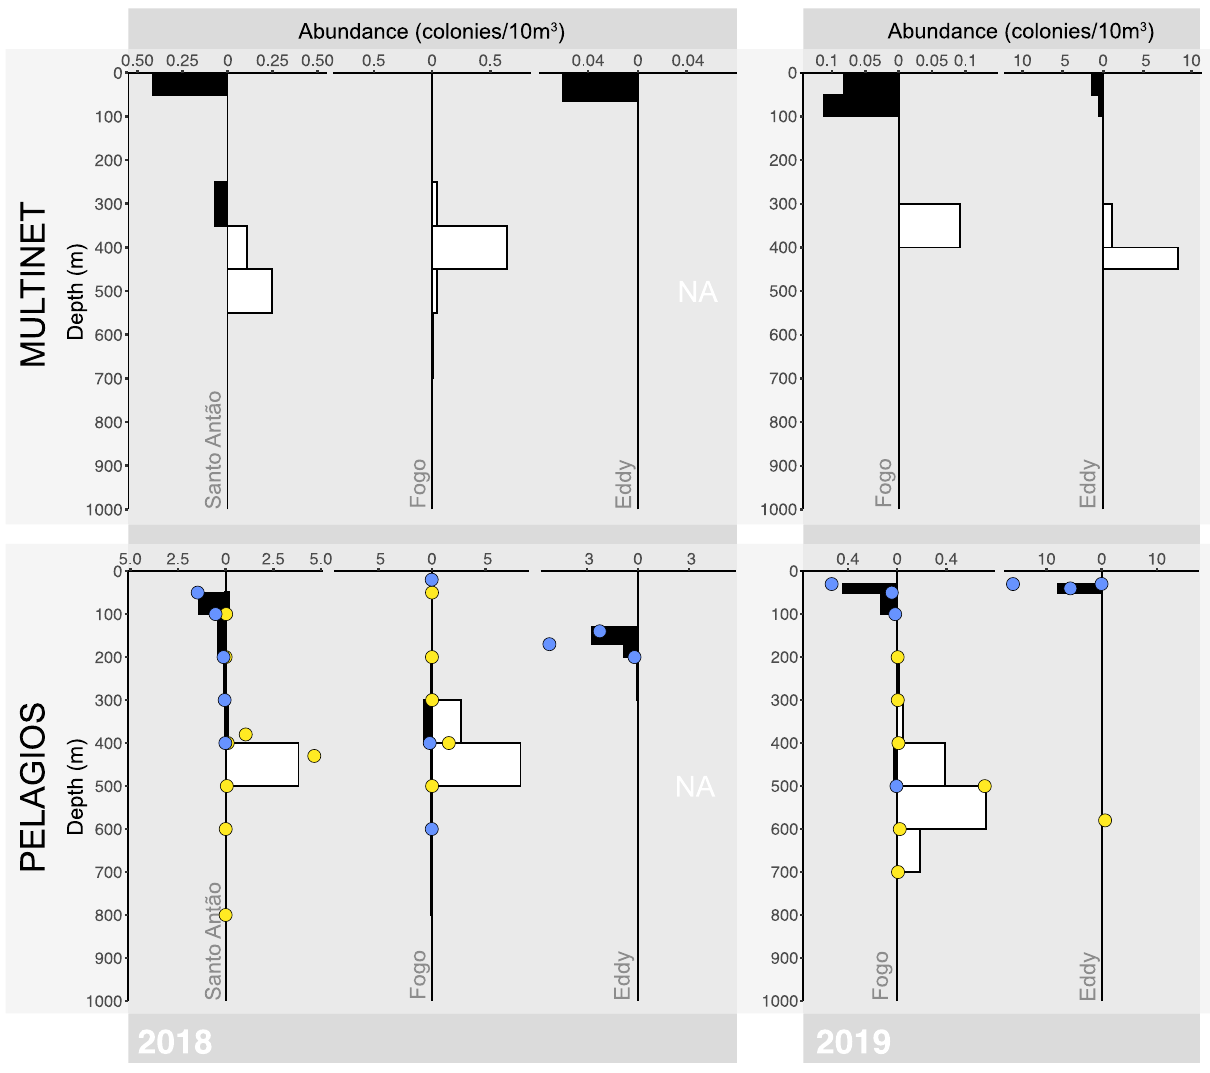
Figure 2. Vertical distribution of P. atlanticum (colonies 10 m −3 ) in the eastern tropical North Atlantic, as caught with the multinet (upper plots) and observed with PELAGIOS (lower plots) in 2018 (left) and 2019 (right). Observations were made at Santo Antão, Fogo and two cyclonic eddies. For the PELAGIOS observations, bars indicate abundance counted during vertical descents of PELAGIOS, while dots indicate horizontal transects. Both day (yellow dots, white bars) and nighttime (blue dots, black bars) observations are